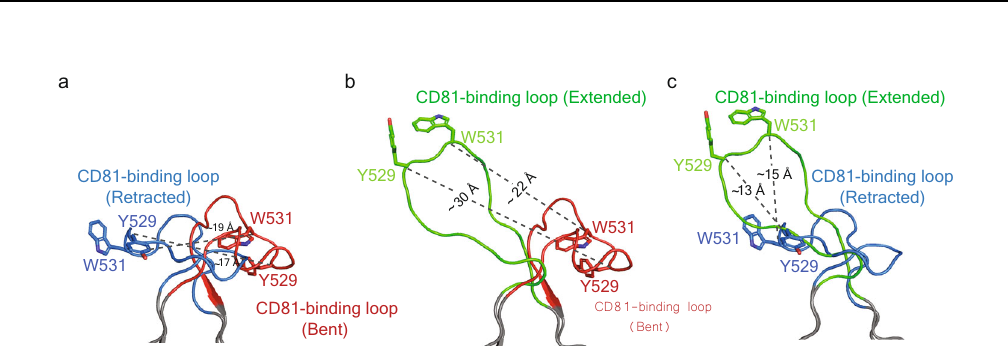
Fig. 4 | Structural comparison of the CD81-binding loop. The superposition of a thebentCD81-bindingloopofE2core+stem(red)withtheretractedCD81-binding loop of eE2 (blue), b the extended CD81-binding loop of Δ HVR1 eE2 (green) and bent CD81-binding loop of E2core+stem (red), and c the extended CD81-binding